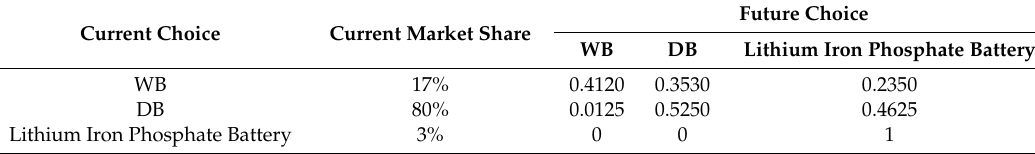
Table 3. Probability